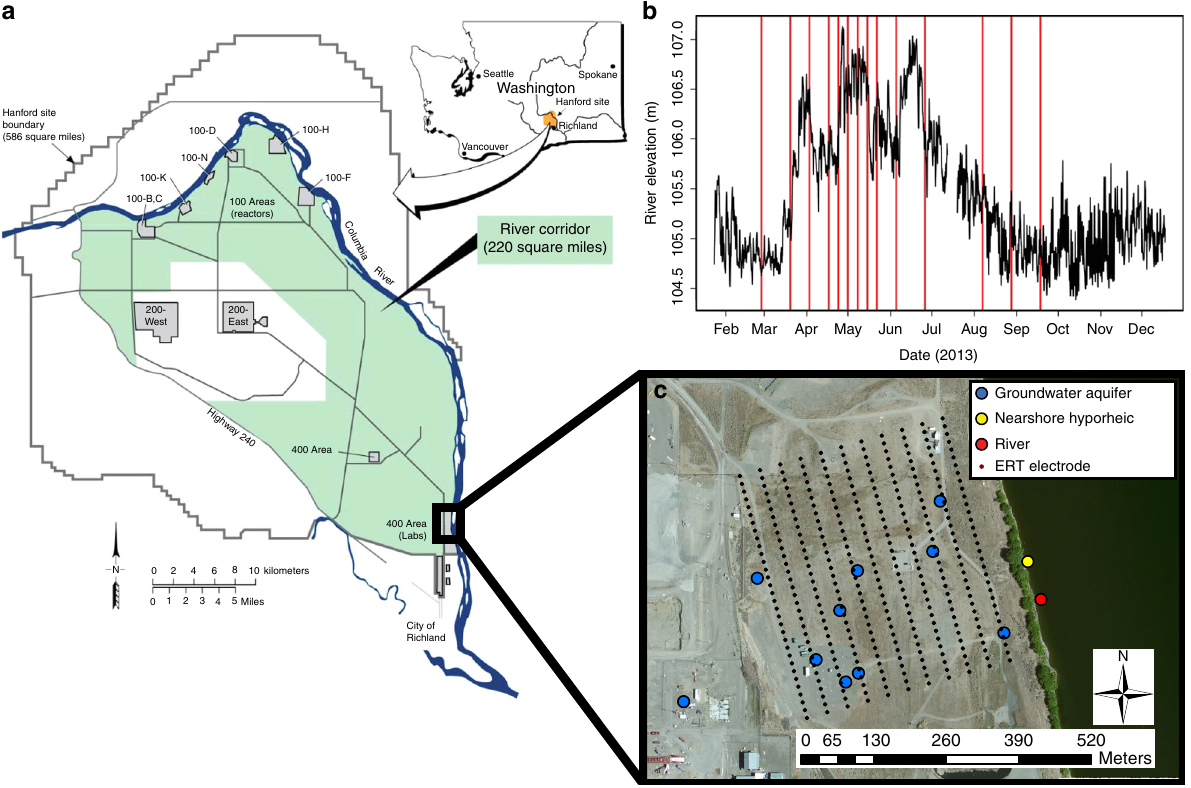
Fig. 2 Spatial and temporal sampling design. a The location of the Hanford site within Washington State and the location of the Hanford 300 Area fi eld site, reproduced from Stegen et al. 1 . b The Columbia River elevation near the fi eld site throughout 2013; vertical red lines indicate sampling times. Sampling times targeted the most dynamic parts of the hydrograph and are not, therefore, evenly spaced. c Sampling locations within the fi eld site where colors indicate different types of sampling locations; red indicates where water was sampled from the river water column, yellow indicates where nearshore hyporheic zone water was sampled from a piezometer placed 1 m below the riverbed, blue indicates where water was sampled from wells accessing the top of the groundwater aquifer, and small black circles indicate locations of geophysical electrodes; map was made using ArcMap